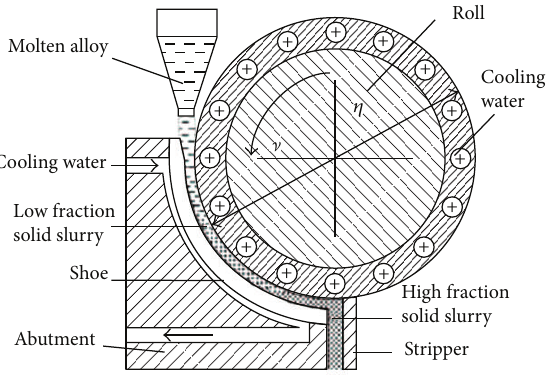
Figure 26: Schematic diagram of SCR process